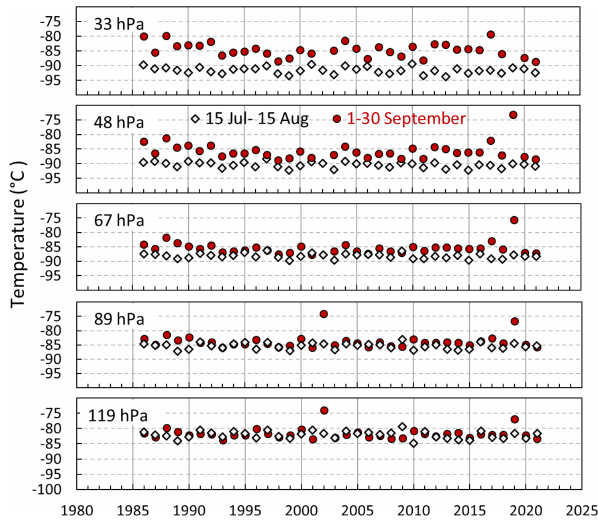
Figure 7. Average 30d winter temperatures from 15 July to 15 August (black diamonds) and during 1–30 September (red cir- cles) from 1986 to 2021. The pressure levels are selected to corre- spond with the ozone loss rates shown in Fig. 6 within the primary ozone depletion altitude region from 119hPa (13.6km) to 33hPa